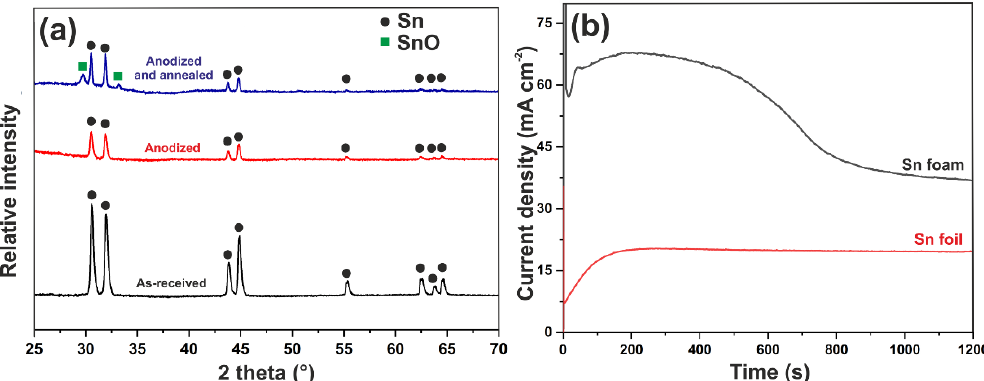
Figure 2. ( a ) X-ray diffraction (XRD) patterns of the as-received Sn foam (black line), Sn foam after 20 min of anodization (red line), and Sn-foam after anodization and annealing in air at 200 °C for 2 h (blue line); ( b ) current density vs. time curves recorded during the anodization process conducted on the Sn foil (red line) and Sn foam (black line) in 1 M NaOH at the potential of 4 V. As-obtained Sn foams were superhydrophilic with a CA < 10° (the image of water droplet just